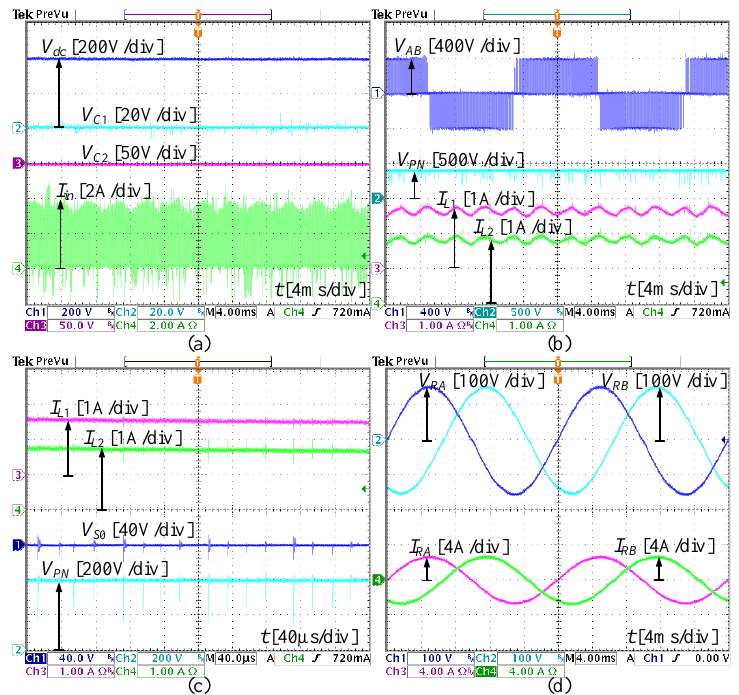
Figure 11. Experimental results for 400 V input voltage. From top to bottom: ( a ) input voltage V dc , capacitor voltages V C 1 , V C 2 , input current I in , ( b ) output line-to-line voltage V AB , DC-link voltage V PN , inductor currents I L 1 , I L 2 , ( c ) inductor currents I L 1 , I L 2 , switch S 0 voltage V S 0 , DC-link voltage